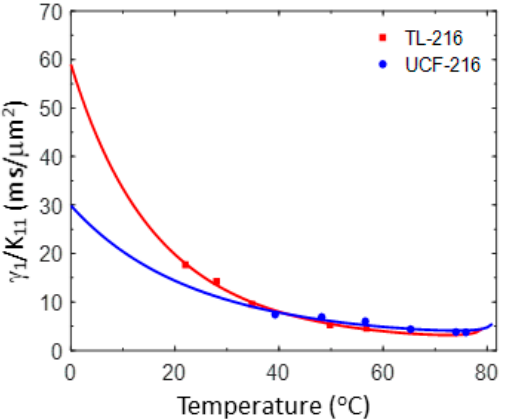
Figure 3. Temperature-dependent viscoelastic constant of TL-216 and UCF-216. Dots are measured data and solid lines are fitting curves using Equation (2). The fitting parameters are listed in Table 2. Table 2. Fitting parameters obtained through Equations (1) and (2).